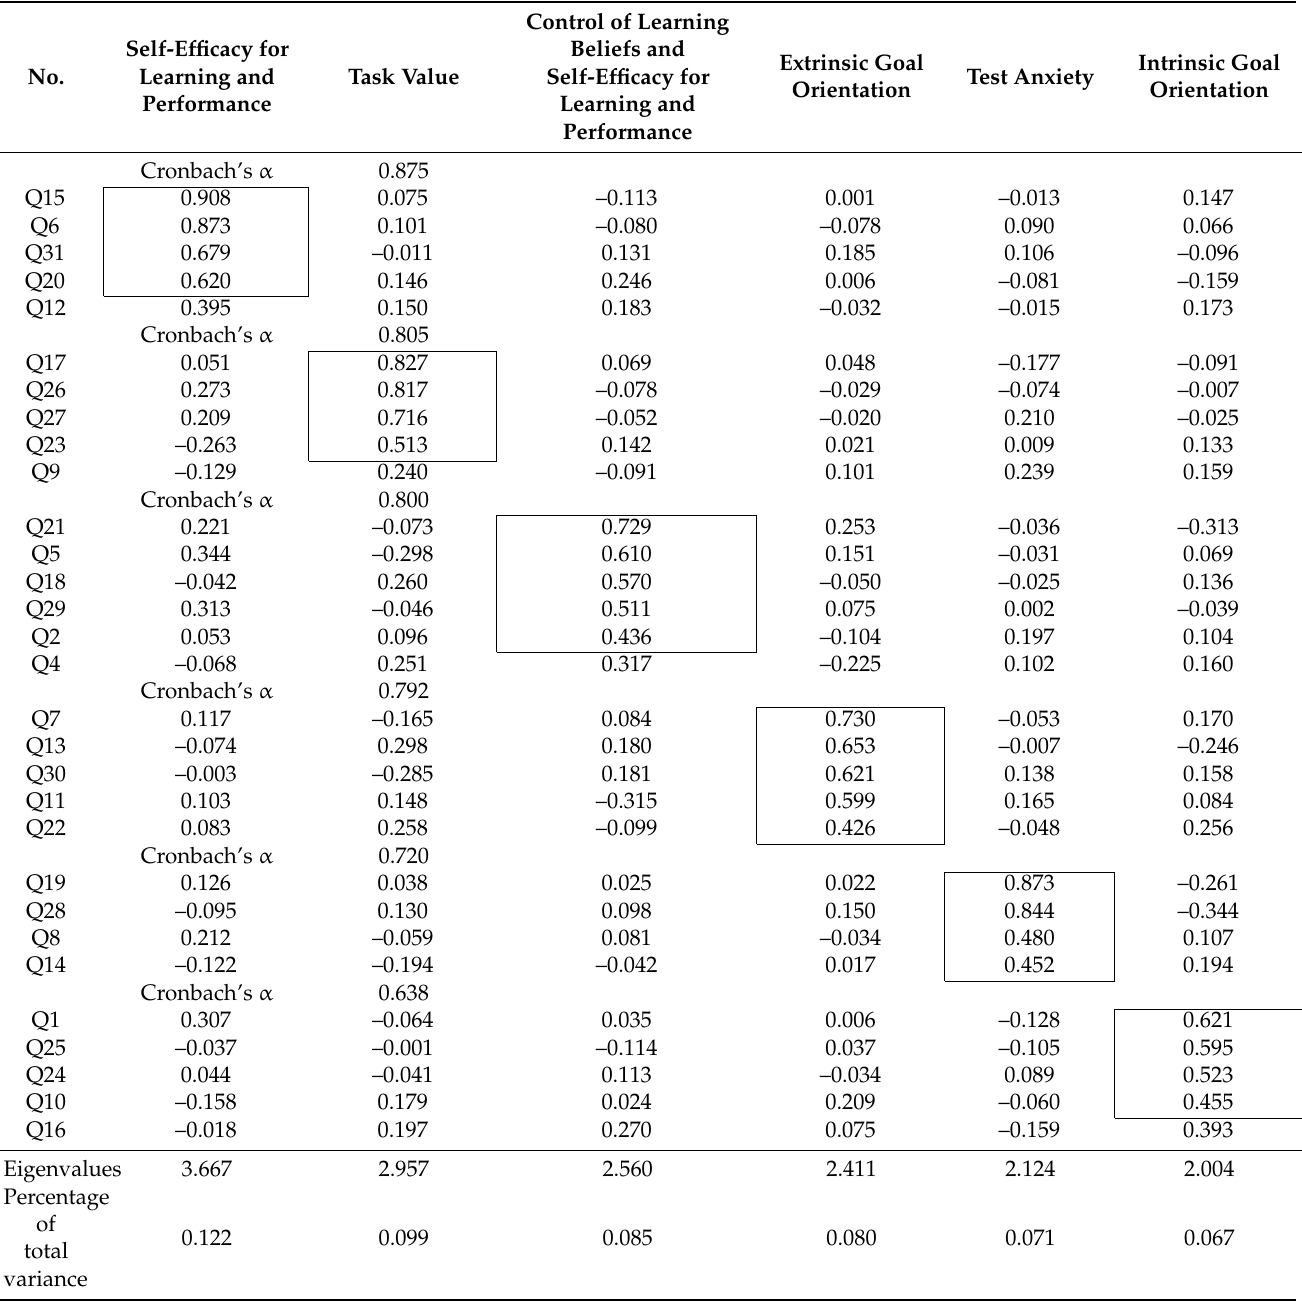
Table 3. Factor loadings and variance explained from an exploratory factor analysis of the Motivation